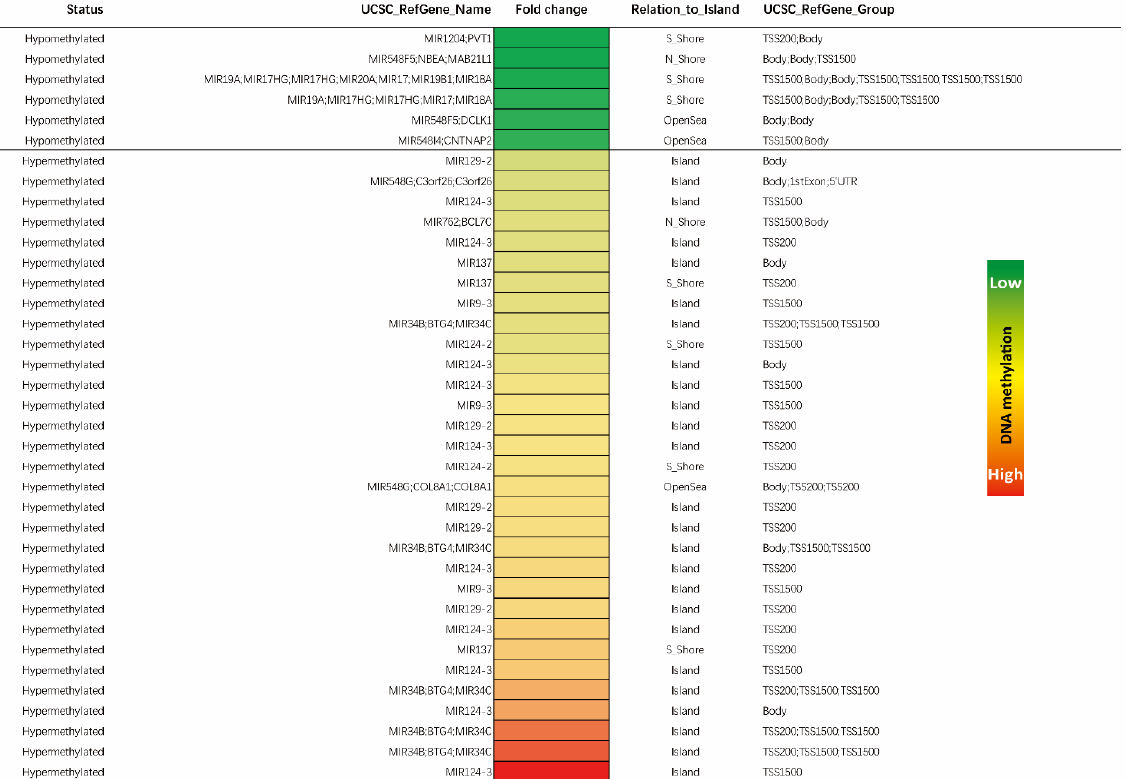
Figure 4. Heat map of differentially methylated miR genes. The heat map showcases all >2-fold differentially methylated CpG sites within miR genes between tumor and normal colorectal samples. A total of 37 unique sites covering 18 miR genes were identified (nine hypermethylated and nine hypomethylated). The color in each small box represents the relative methylation level of the individual positions within genes in colorectal carcinomas as compared to normal colorectal tissue. The light green color to red color represents a low to high relative methylation status of the individual site, respectively. For the sake of completeness, genes with overlapping open reading frames sharing similar genomic locations are also shown.